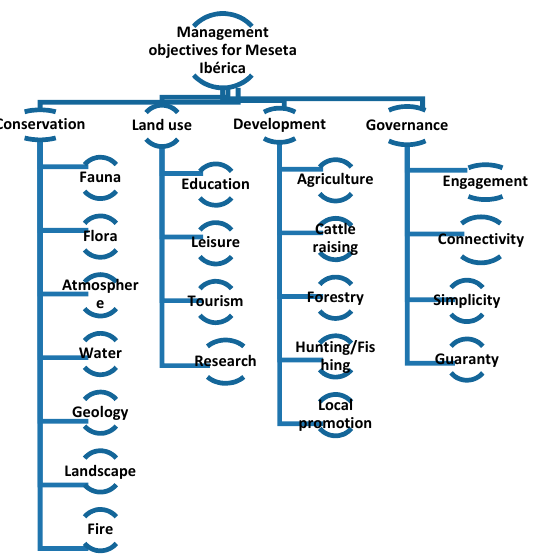
Figure 2. Hierarchical structure of the management objectives defined for the protected rural reserve Iberian Plateau.